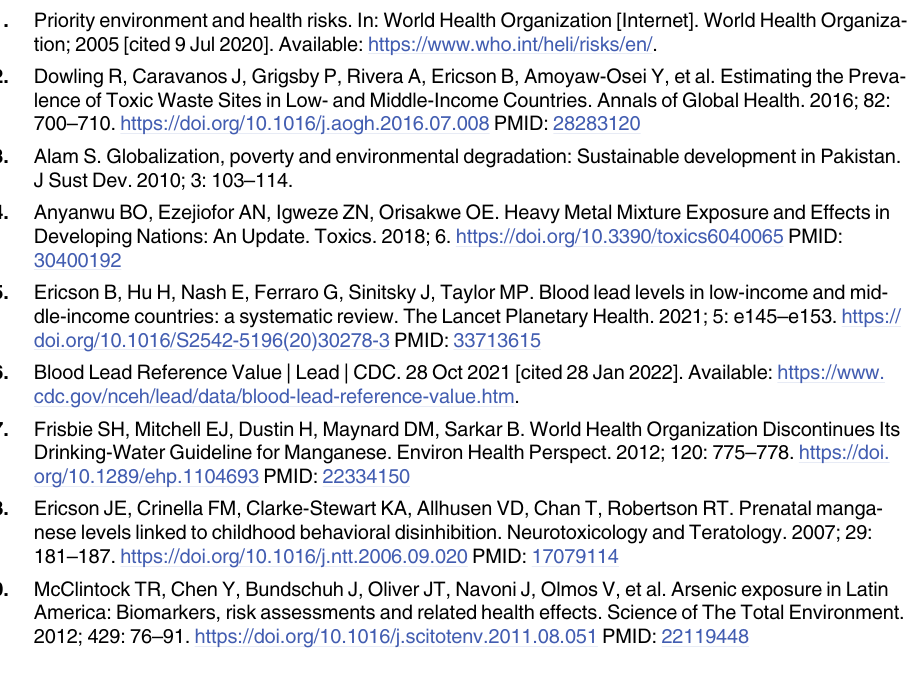
S1 Table. Summary of the studies included in the systematic